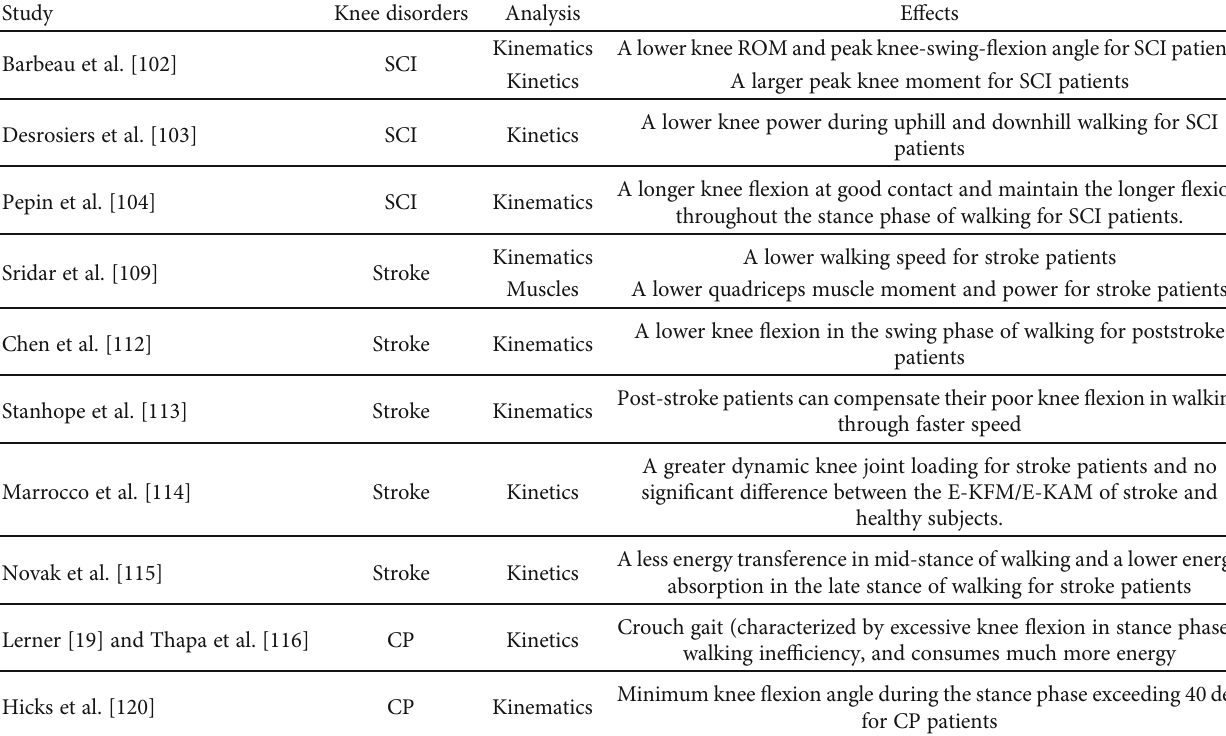
Table 14: Overview over the biomechanical e ff ects of SCI, stroke, and